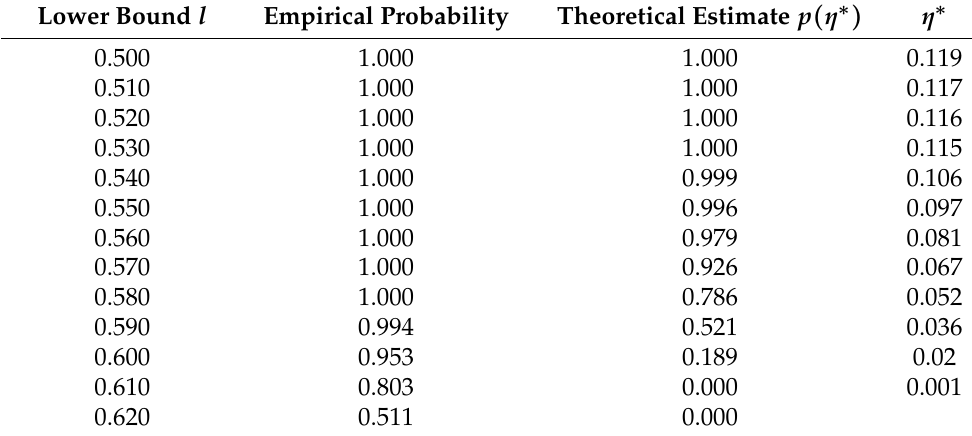
Table 3. Simulation results for B(0.1, 2), number genes = 20,000, proportion significant = 0.1, real power limit = 0.620014.